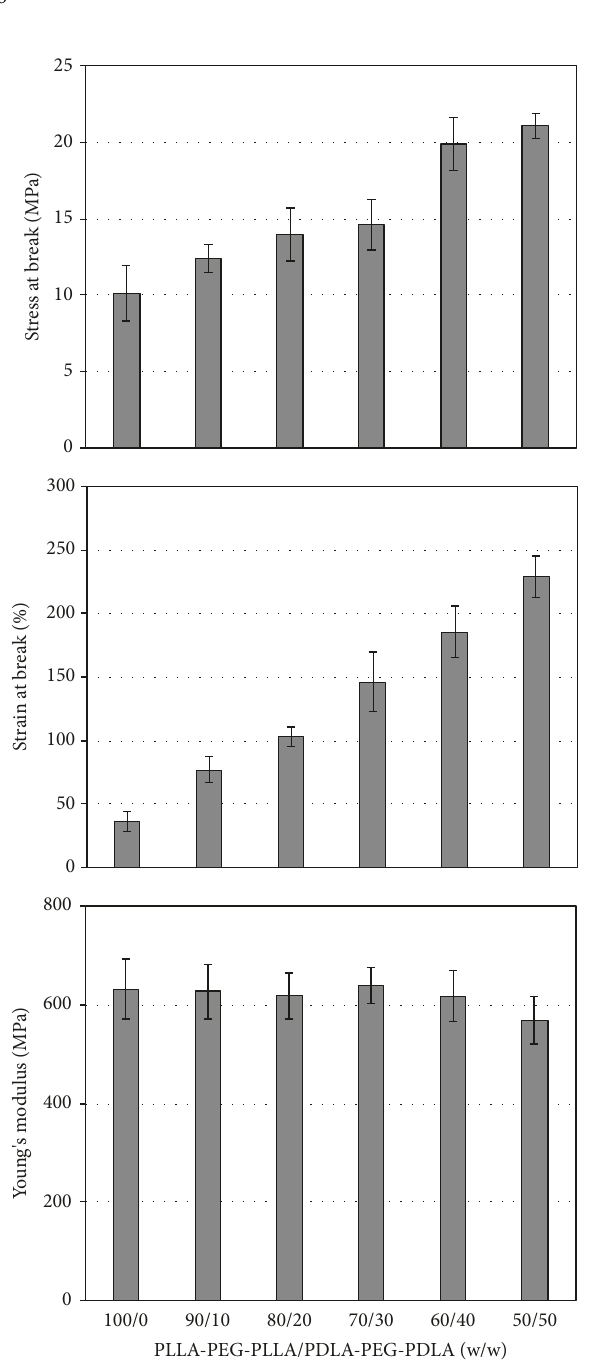
Figure 5: Tensile properties of PLLA-PEG-PLLA/PDLA-PEG- PDLA blend films.